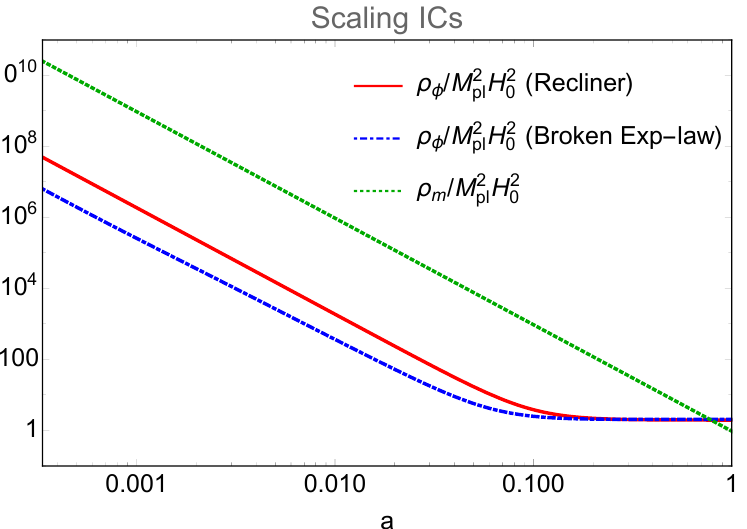
Figure 3. Evolution of the matter density ρ m (green dotted line) and the scalar-field density ρ φ for the two types of potentials explored: the Recliner one (red solid line) and Broken exponential-law (blue dot-dashed line). The parameters for the Recliner potential are: α 1 = 1.4 × 10 − 4 , α 2 = 1 and the ICs are x i = y 1, i = 0.03, λ 1, i = 40.83, y 2, i = 0.899 × 10 − 5 and λ 2, i = 0.01. The parameters for the Broken exponential-law potential are: p 1 = 1, n 1 = 5, q 1 = 11, p 2 = 1, n 2 = 7, q 2 = 3.4 and the